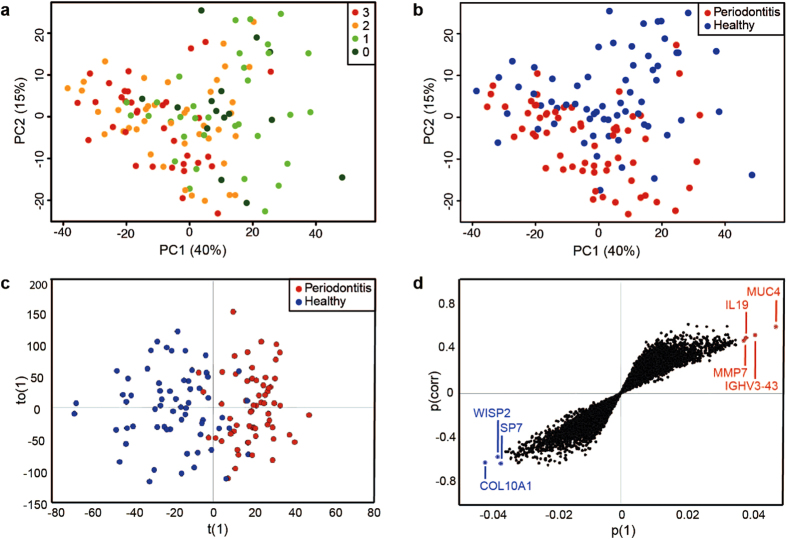
Multivariate analysis of gene expression data from gingival biopsies.(a) Principal component analysis (PCA) score plot with the two first principal components (PC1 and PC2) plotted on the x- and y-axis. Each data point representing one sample is color-coded according to the extent of inflammatory cell infiltration (evaluated in biopsies adjacent to those used for gene expression analysis and harvested at the same time). Dark green = 0 (no evidence of inflammatory infiltration), light green = 1 (slight inflammatory infiltration), orange = 2 (moderate inflammatory infiltration) and red = 3 (severe inflammatory infiltration). (b) The PCA score plot with data points from patients with periodontitis and healthy control subjects represented in red and blue, respectively. (c) Orthogonal projections to latent structures discriminant analysis (OPLS-DA) score plot for gingival biopsies from patients with periodontitis (red) and healthy control subjects (blue). The between-group variation predictive component, t(1), is plotted against the within-group variation orthogonal component, to (1). (d) S-plot of the OPLS-DA data showing the magnitude of each gene’s contribution to the separation, p(1), in relationship to its significance, p(corr). The genes contributing the most to the periodontitis group (highlighted in red) are, from left to right, MMP7, IL19, IGHV3-43, and MUC4. The genes contributing the most to the healthy control group (highlighted in blue) are COL10A1, WISP2, and SP7.